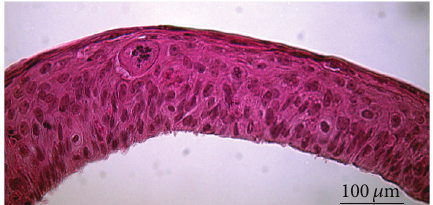
Figure 3: Hematoxylin-eosin (HE) staining shows that the epithelium is occupied with dysplastic cells with differentiation tendency from basal layer toward superficial layer.